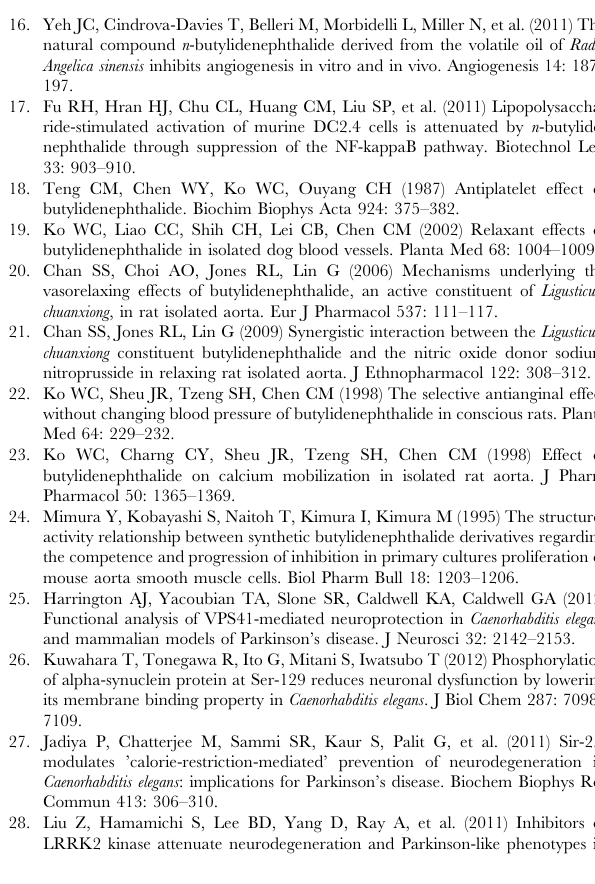
Figure S1 The neuroprotective effects of n -butylide- nephthalide, curcumin, N-acetylcysteine and vitamin E on 6-OHDA-induced degeneration of DA neurons in C.